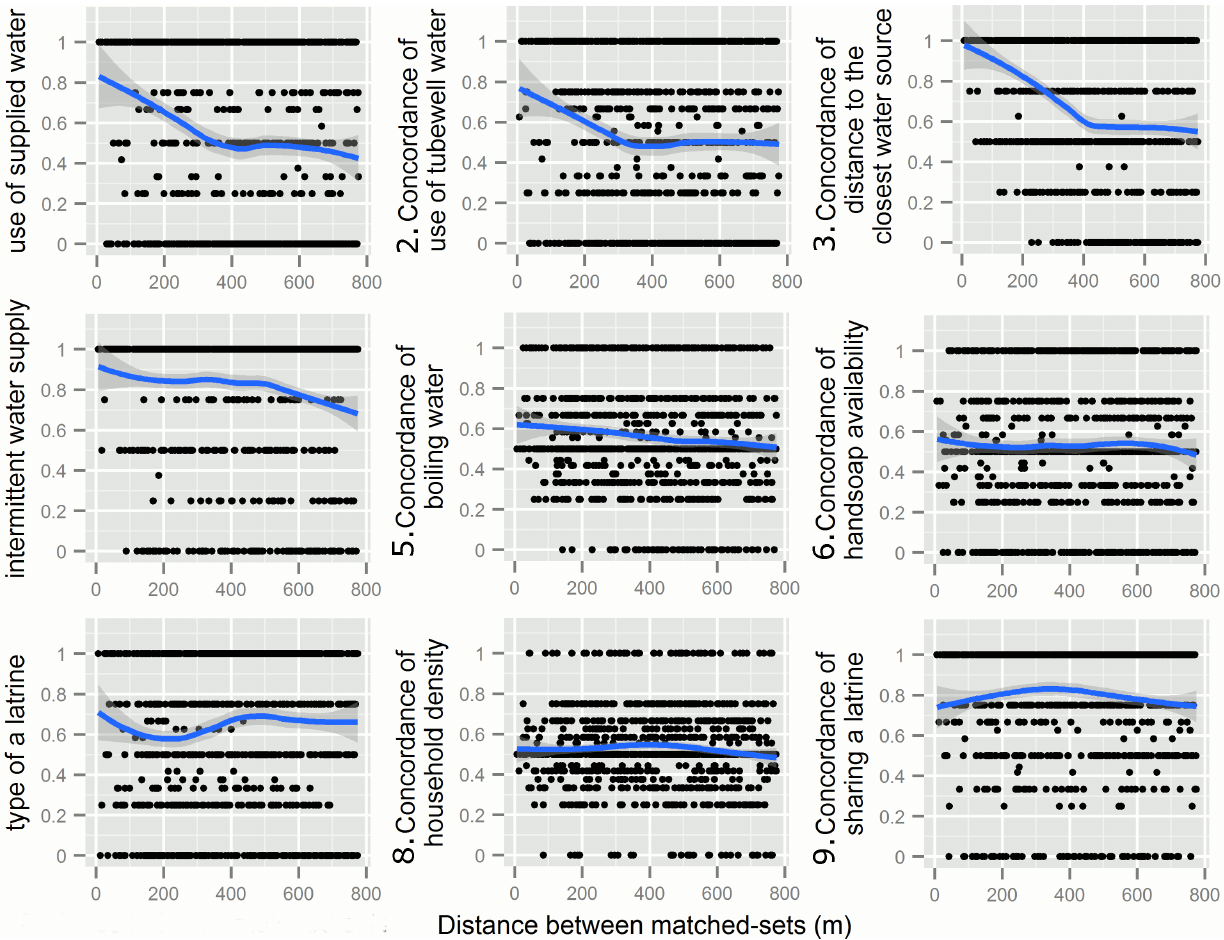
Fig 3. Clustering of exposures beyond the spatial extent of matched-sets. We visually assessed how between matched-sets concordance for each exposure varied with the distance between centroids of matched-sets using non-parametric locally weighted polynomial regression models (LOESS). The shaded area represented 95% confidence intervals of bootstrapped routine from 1,000 simulations. The first 5 exposures related to water source (Fig 3.1 – 5) showed decreasing concordance between matched-set over space, suggesting clustering of exposures beyond spatial extent of matched-set.